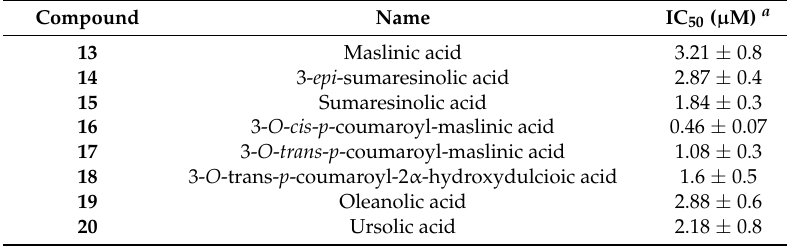
Table 1. IC 50 values of compounds 13 – 20 isolated from leaves of Miconia albicans